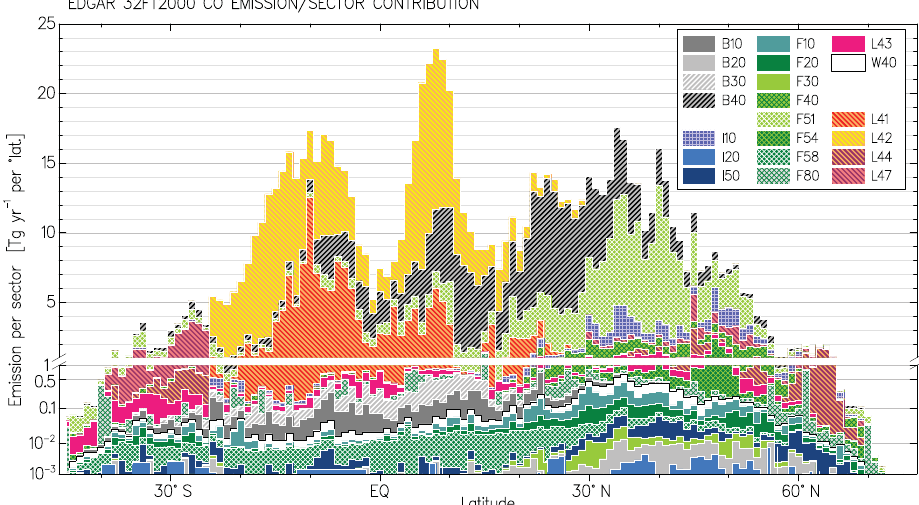
Figure 1. Relative contributions of emission sectors to the overall emission of CO in the EDGAR inventory. Values are given in Tg ( CO ) yr − 1 per degree latitude. Note that the original EDGAR biomass burning sectors L41, L42, L44 and L47 are presented here for comparison only. They are being substituted (see text) by the GFED inventory. Note the change in ordinate axis scale at the value of